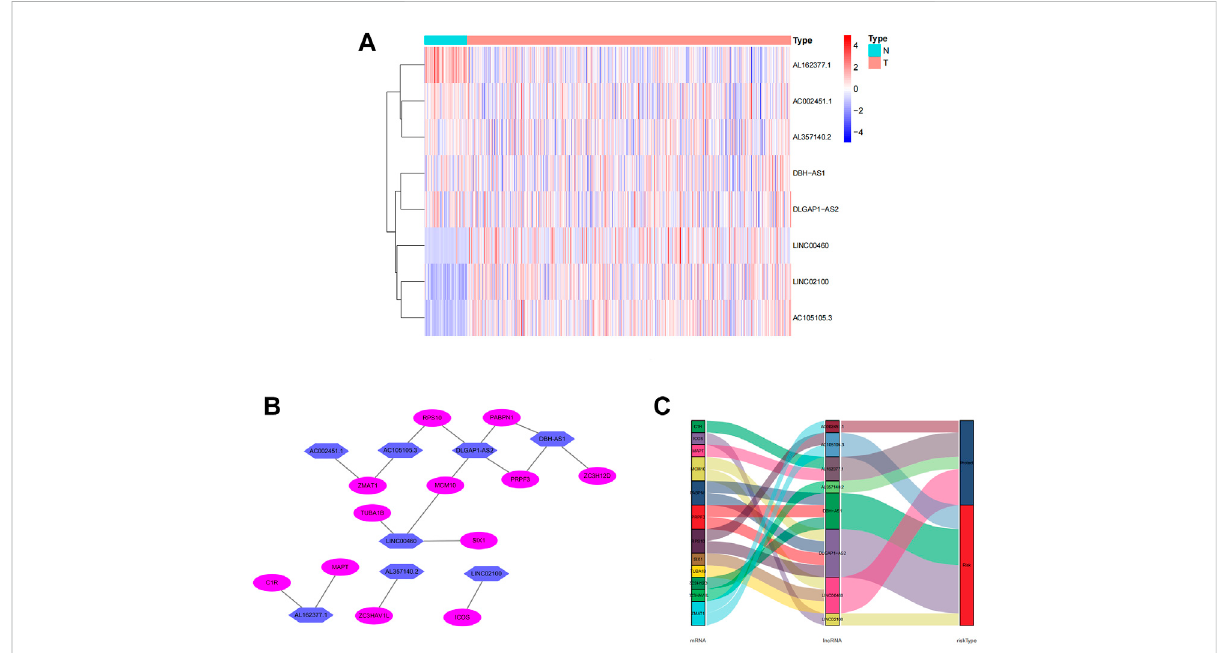
FIGURE 3 Expression levels of eight CCCH-type zinc fi nger-associated lncRNA and lncRNA-mRNA networks in predicted signals. (A) Expression levels of eight CCCH-type zinc fi nger-associated lncRNA in ccRCC and normal tissues. (B) Co-expression networks of prognostic CCCH-type zinc fi nger- associated lncRNAs. (C) Multinograms of prognostic CCCH-type zinc fi nger-associated lncrna. LncRNAs, long-chain non-coding RNAs; ccRCC, renal clear cell carcinoma; N, normal; T,